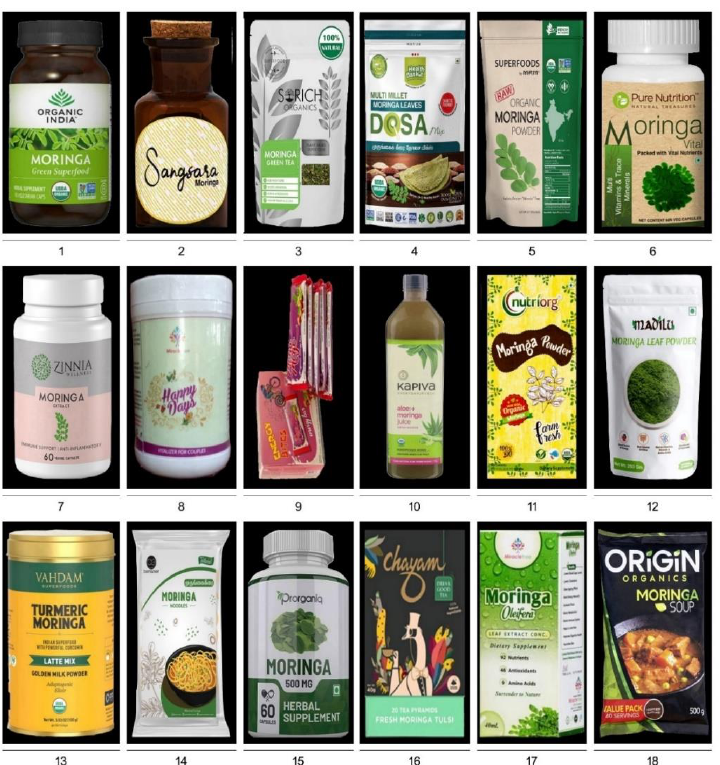
Plants 2022 , 11 , x FOR PEER REVIEW Figure 4. Moringa commercial functional food products. Details of products 1 – 18 are listed in Table Figure 4. Moringa commercial functional food products. Details of products 1–18 are listed in Table 4. 4.